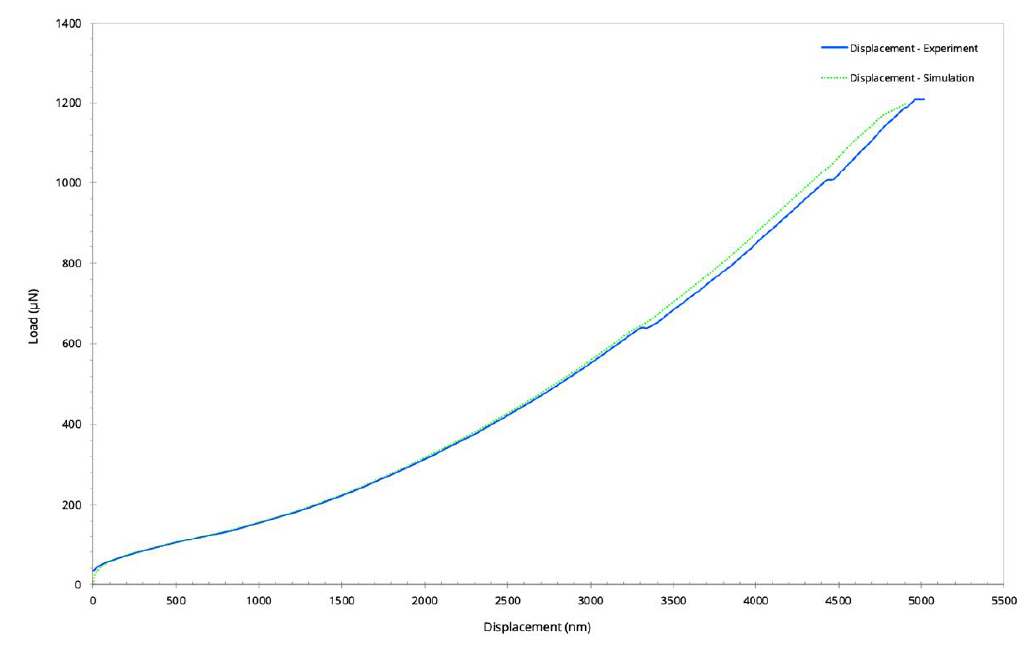
Figure 10. The obtained load-displacement curves from the micro-indentation experiment and the simulation during the loading.